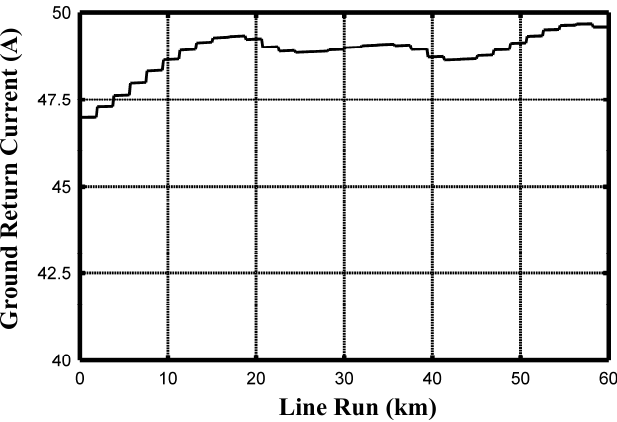
Figure 16. Ground return current magnitude for CB UGC without PTs.